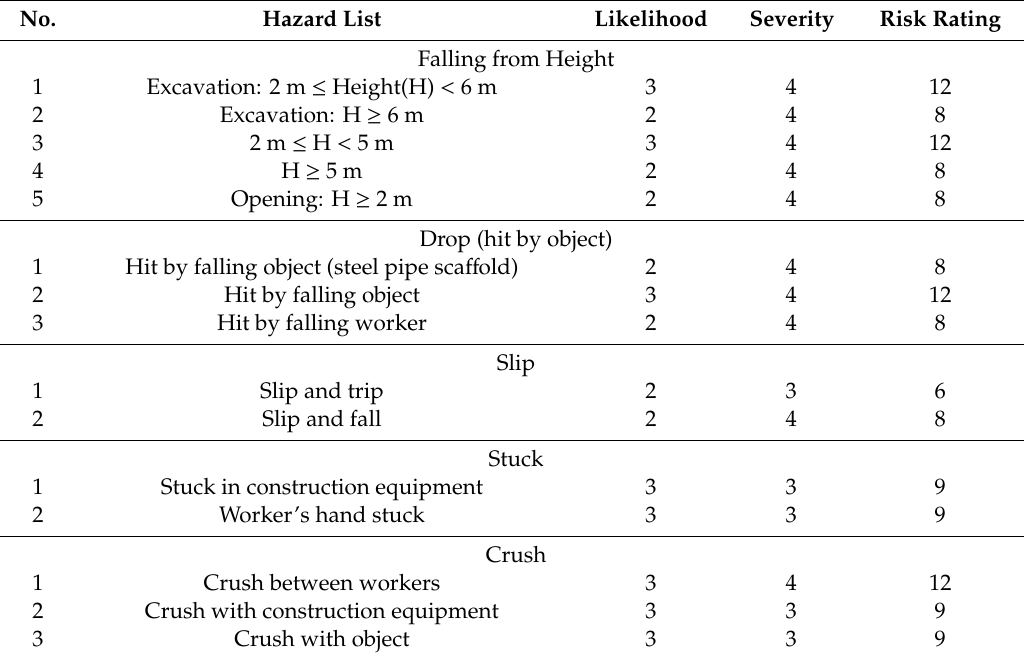
Table 3. Risk rating table for design-for-safety